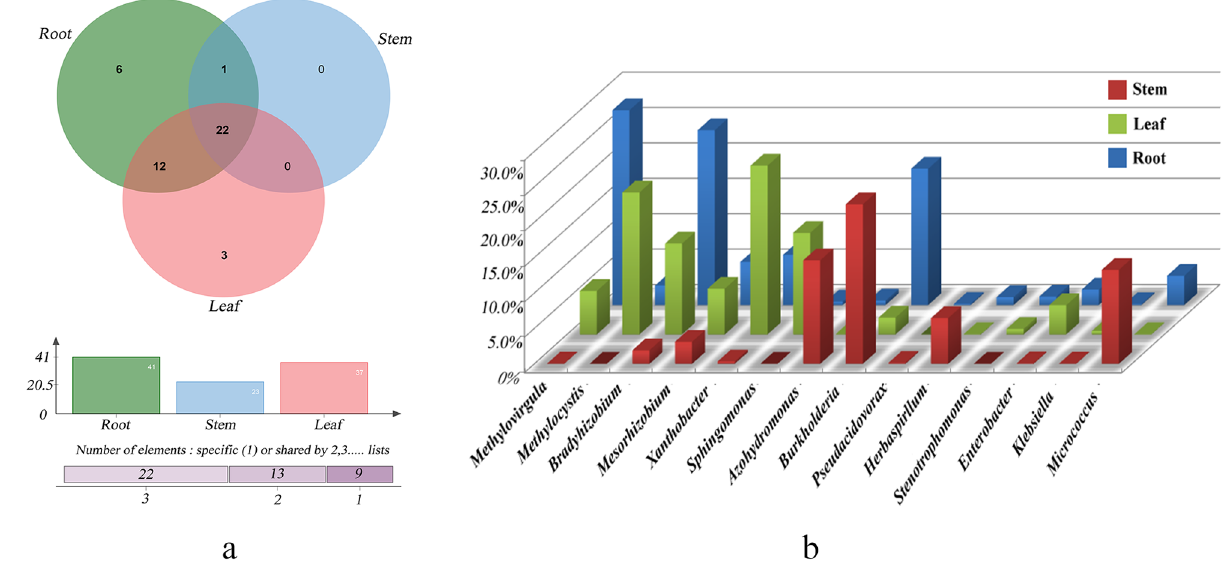
Fig 4. Venn diagram (A) and bar chart (B) for the genus levels of species composition of three tissue samples.